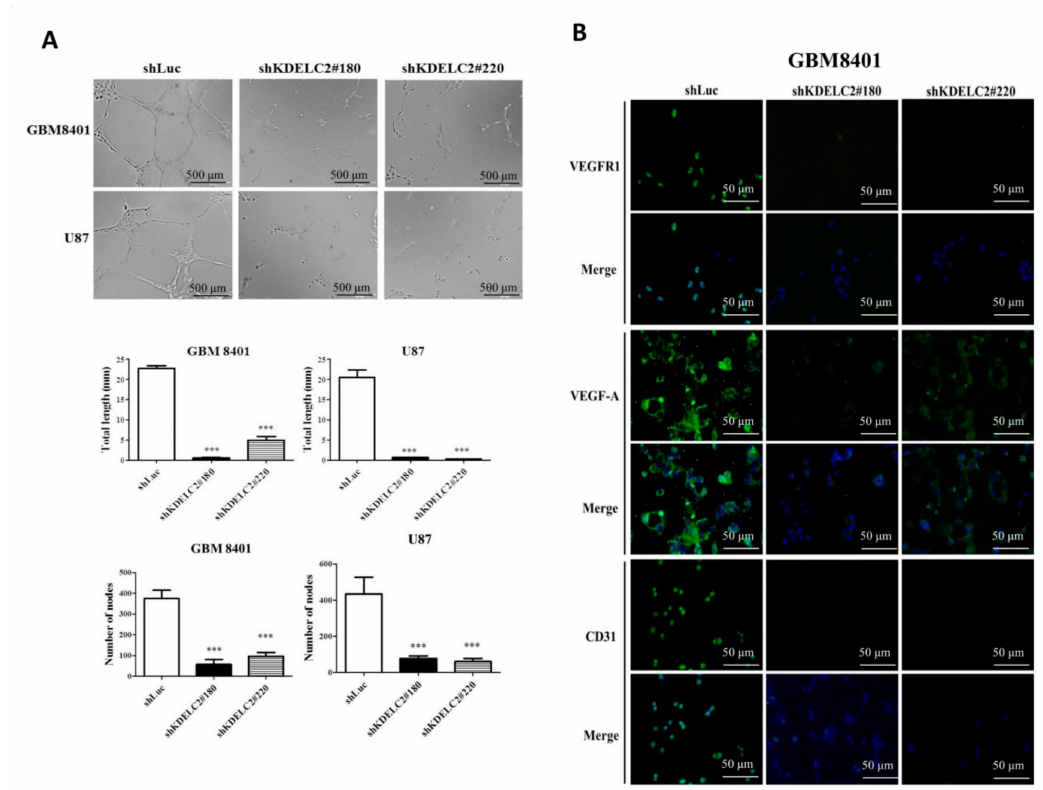
Figure 8. KDELC2 knockdown inhibited glioblastoma (GBM) angiogenesis. ( A ) HUVECs with supernatants from cultured GBM8401 with shKDELC2 transfection suppressed tube lengths and nodes. ( B ) Immunofluorescence staining images show decreased expression of VEGFR1, VEGFA, and CD31 in shKDELC2-transfected GBM8401. Bars, means ± SEM. * p < 0.05; ** p < 0.01; *** p < 0.0001. 3.10. KDELC2 Knockdown Downregulated PI3k / mTOR / Akt, MAPK / ERK, and NF / kB Signaling Pathways by Suppression of Notch Receptor Expression KDELC2 knockdown not only inhibited Notch 1–3 mRNA expression but also decreased KDELC1 and pofut1 expression (Figure 9A,B). As the activated Notch receptors possibly upregulated the phosphoinositide 3-kinase (PI3k) / mTOR / Akt, mitogen-activated protein kinase (MAPK) / ERK, and nuclear factor kappa-light-chain-enhancer of activated B-cell (NF / kB) signaling pathways, we surveyed some representative factors of the above signaling pathways in shLuc and shKDELC2-transfected GBMs. Compared with the shLuc group of GBM8401 and U87 GBMs, our results demonstrated lower expression of phosphorylated PI3k (p-PI3k), phosphorylated mTOR (p-mTOR), phosphorylated Akt (p-Akt), phosphorylated MEK (p-MEK), phosphorylated ERK (p-ERK), and phosphorylated NF / kB p65 (p-NF / kB p65) and higher PTEN protein expression in the shKDELC2 GBMs (Figure 9C). Additionally, KDELC2 knockdown of GBM cell lines also showed suppression of transforming growth factor- β (TGF- β ), p-GSK-3 β , and p-90RSK expression (Figure 9C). In conclusion, KDELC2 overexpression could induce GBM growth by upregulating Notch, TGF- β , PI3k / mTOR / Akt, MAPK / ERK, and NF / kB signaling